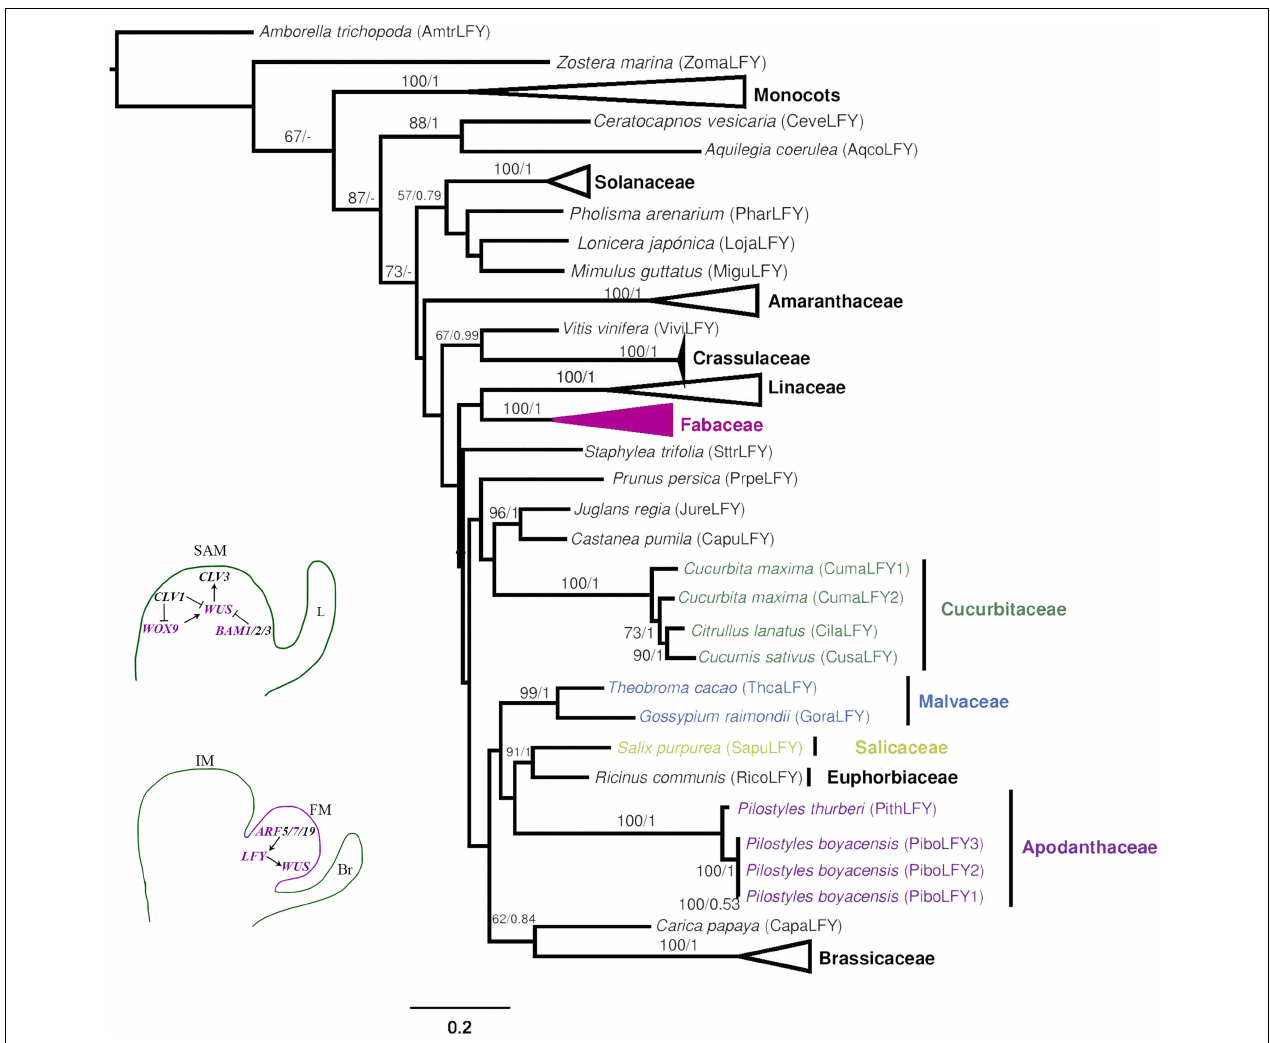
FIGURE 7 | Maximum likelihood reconstruction of the LEAFY gene lineage. Schemes in the bottom left follow the conventions in Figure 2 .